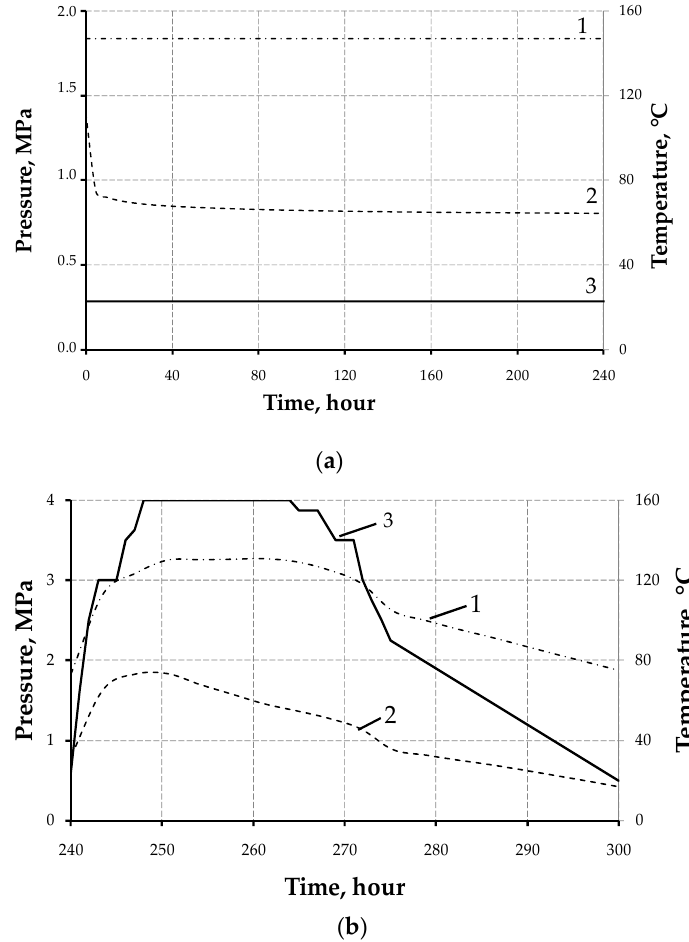
Figure 6. Comparison of the evolution of the normal pressure on the mandrel surface: ( a ) winding stage, ( b ) polymerization stage. 1—Elastic model of mandrel material behavior; 2—thermo-viscoelastic model of mandrel material behavior; 3—temperature regime.